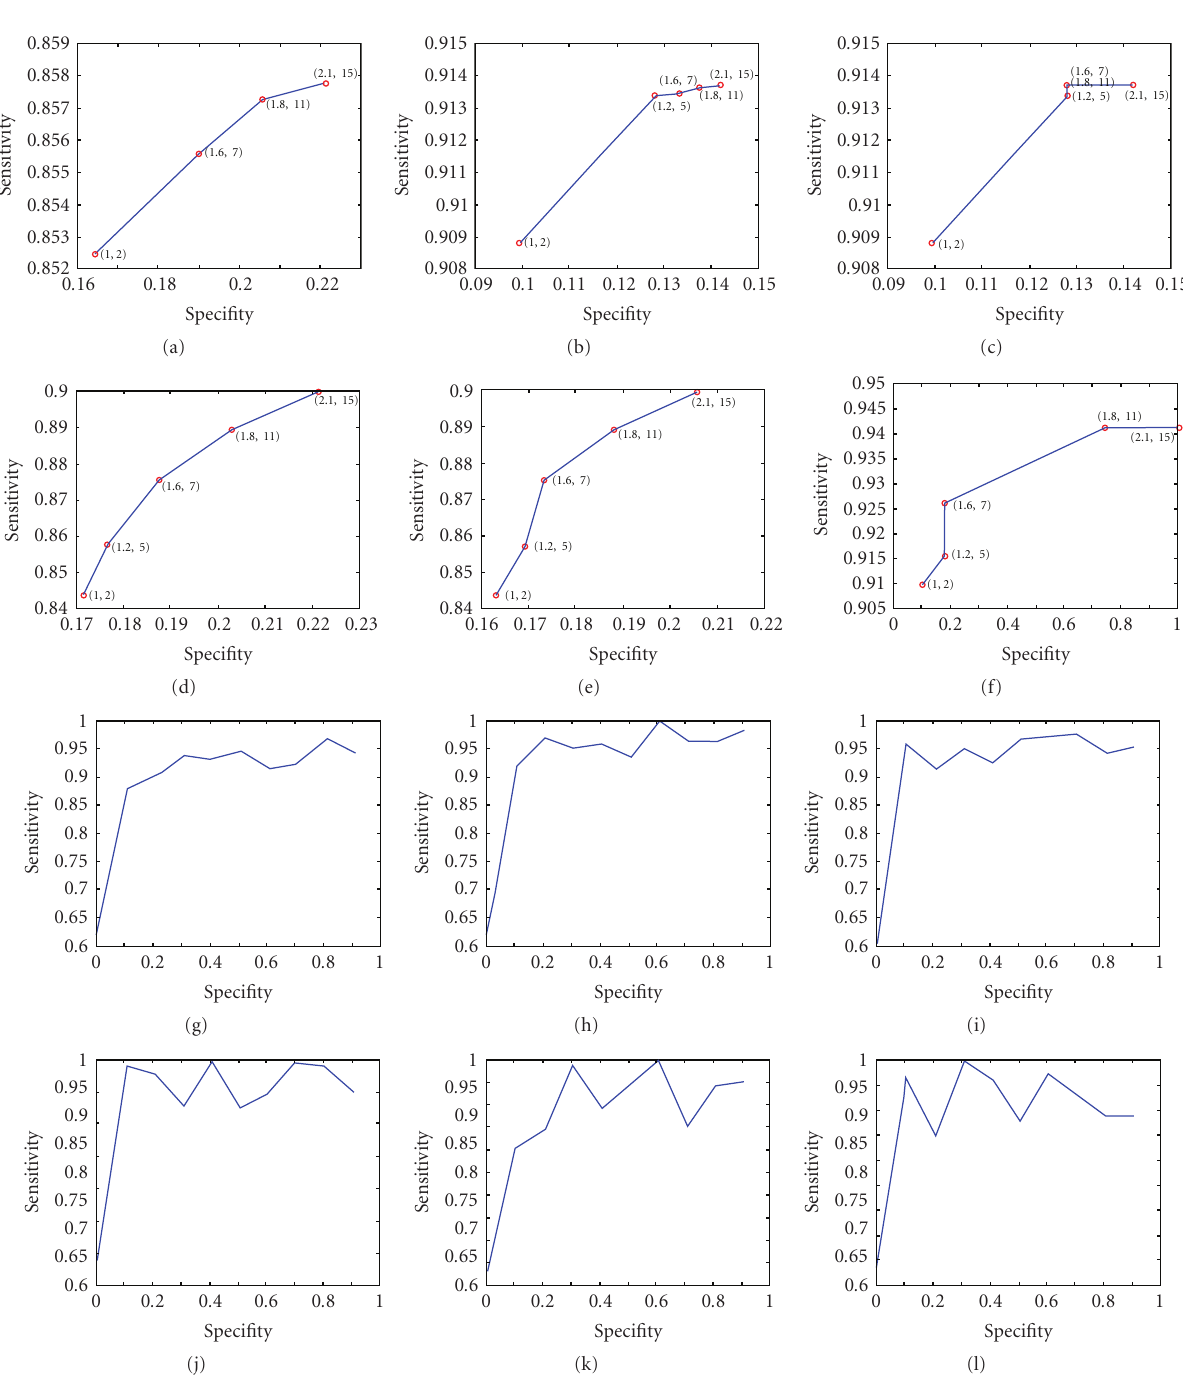
Figure 4: Comparative ROC curves between three full scans and three VWP-based scans: (a) case “2” vasculature with drusen, (b) for the more homogenous background vasculature in “1”, (c) extended drusen as in “3”. The homogenous vasculature in “b” gives a more straight relationship between sensitivity and specificity as a result of a uniform spatial distribution of FP’s and TP’s that does not allow relatively large variations as our threshold and VP pairing area radius increase. As for the guided scans the most notable observation is that SE is increasing less rapidly in the full scan case as observed in full scan graphs (d), (e) and (f) than in guided scan graphs (a), (b), and (c) as a result of faster TP detection o ff ered a prior from VWP map. The Graphs (g), (h), and (i) show the results using double sided dual mode GS-MF on same vasculatures as those for which (a), (b), and (c) stand for. In Graphs (j), (k), and (l), ROC graphs are shown for the RG detection technique, the CL-based technique and three seed point technique for every branch of the vasculature greater in length than 10 pixels. All non VWM-guided techniques (g) ··· (l) have a steeper ROC for small specificity (SP) values. This shows when the number of FN is lowered the improvement/decrease of the FP is proportionally larger than with VWM guided detection. Our method directly addresses the FP decrease problem. Moreover, when we use more elaborated filters [spatially modulated dual mode double sided] the performance variation after the critical point where SE reaches a local peak (at SP ∼= . 99,SE ∼= . 1) is significantly lower than with RG, CL-based on 3 seed